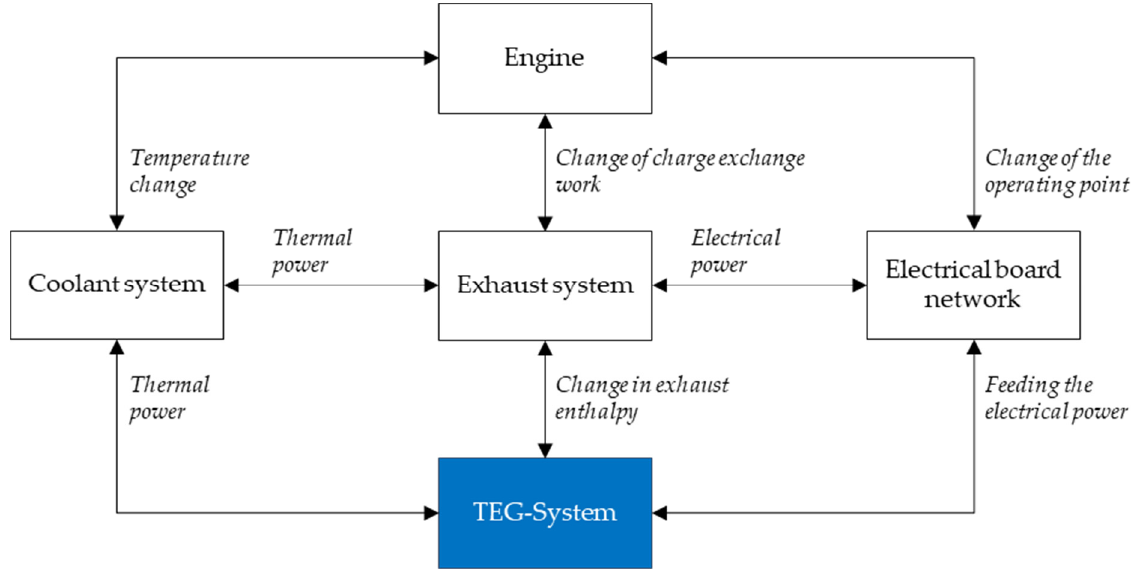
Figure 7. Interactions between the TEG system and the relevant vehicle subsystems.